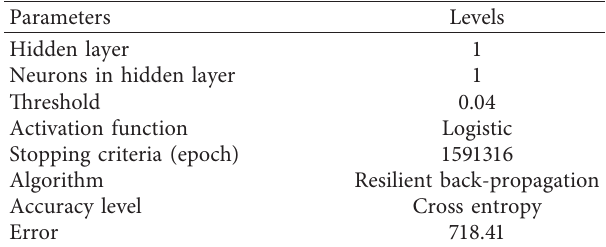
Table 10: Tuning parameters for the feed-forward neural network